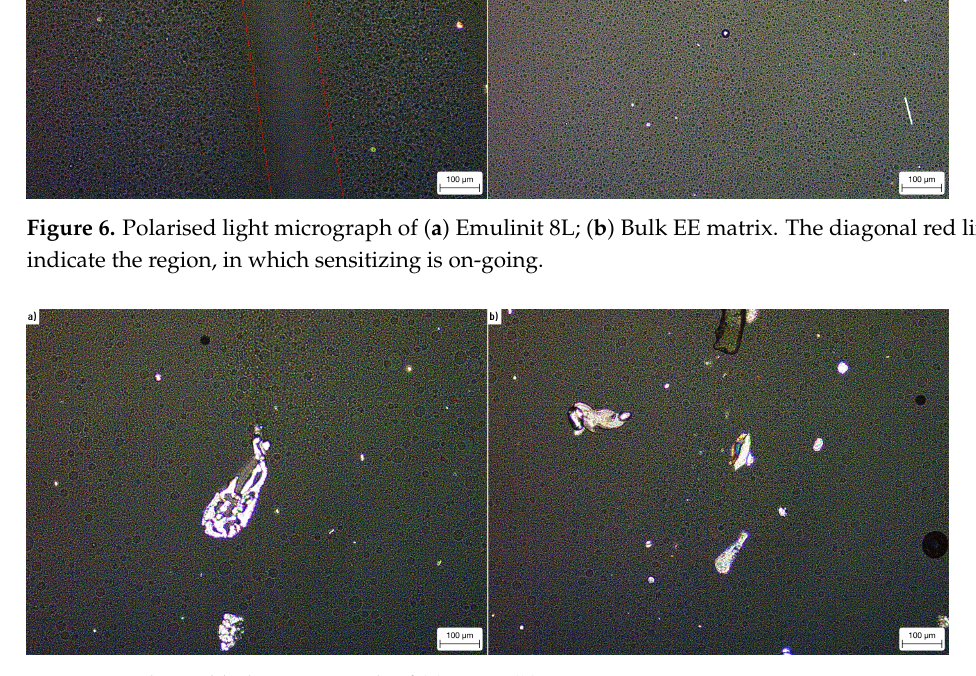
Figure 7. Polarised light micrograph of ( a ) BK-1; ( b ) BK-2.